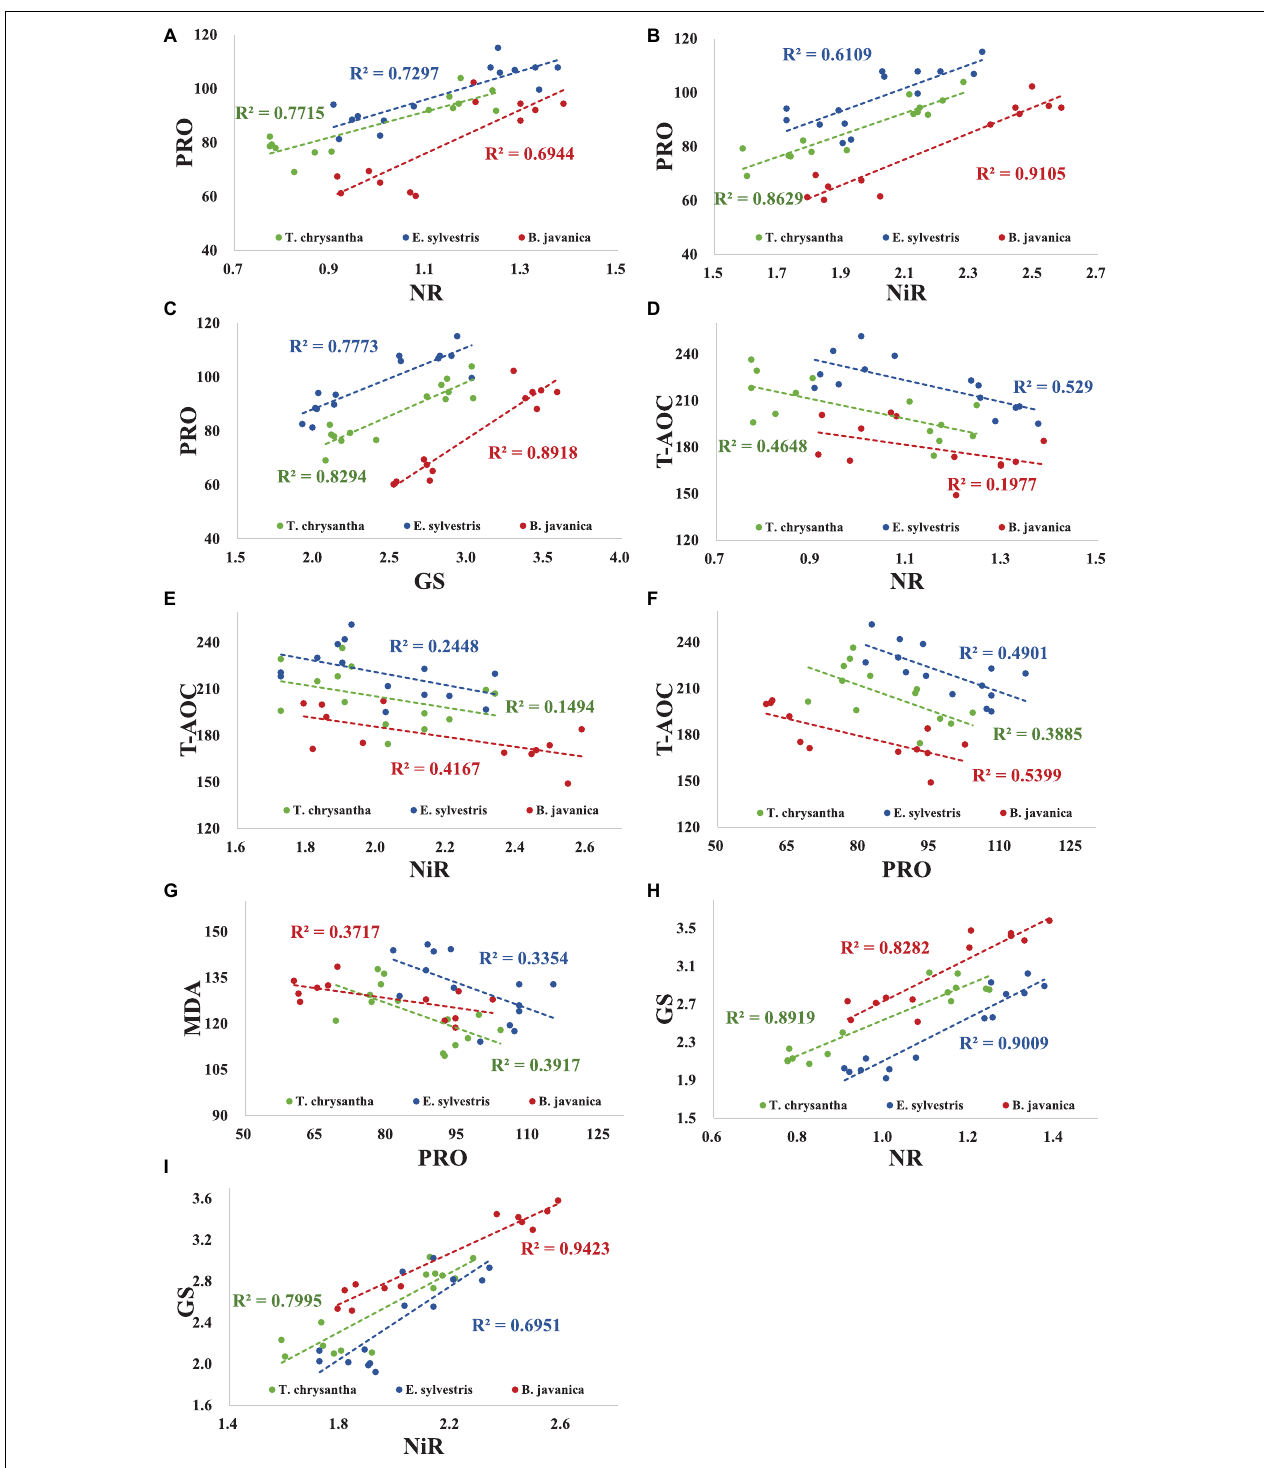
FIGURE 2 | Correlation among physiological indices of Tabebuia chrysantha , Elaeocarpus sylvestris, and Bischofia javanica under nitrogen addition plus drought (N+D) and drought (D) treatments. PRO concentration vs. NR activity (A) , PRO concentration vs. NiR activity (B) , PRO concentration vs. GS activity (C) , T-AOC vs. NR activity (D) , T-AOC vs. NiR activity (E) , T-AOC vs. PRO concentration (F) , MDA concentration vs. PRO concentration (G) , GS activity vs. NR activity (H) , GS activity vs. NiR activity (I) .